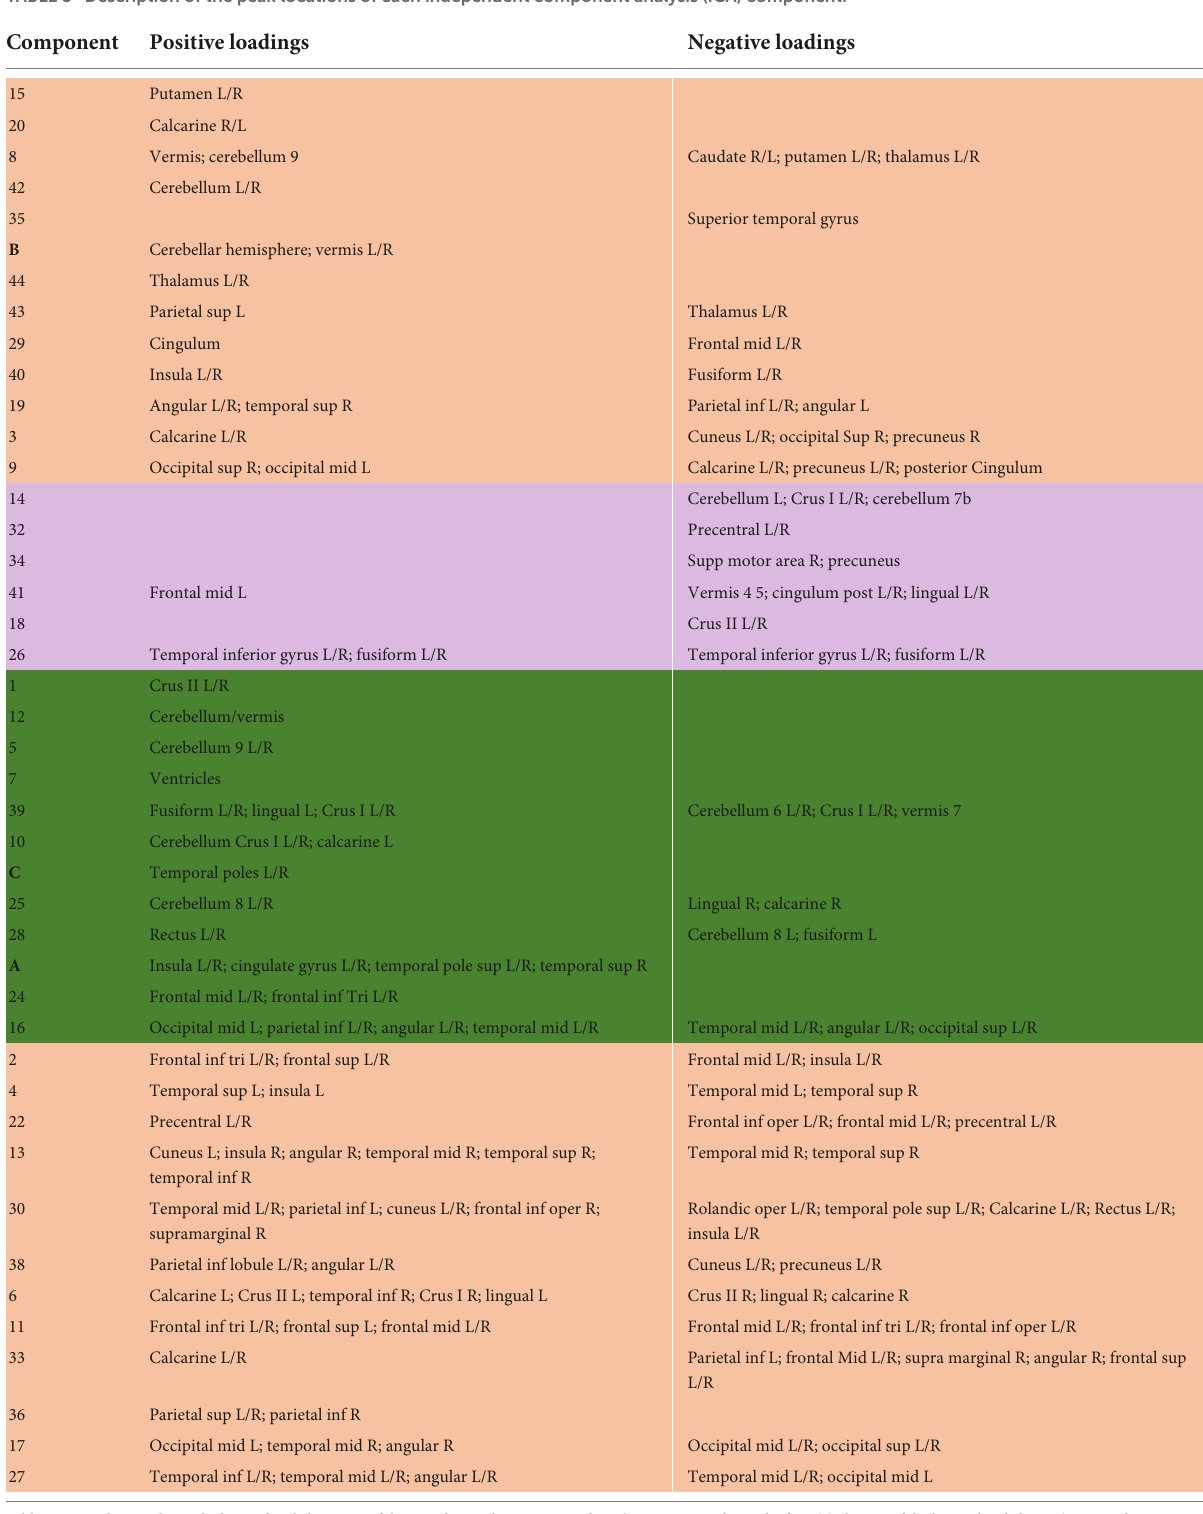
TABLE 5 Description of the peak locations of each independent component analysis (ICA) component.